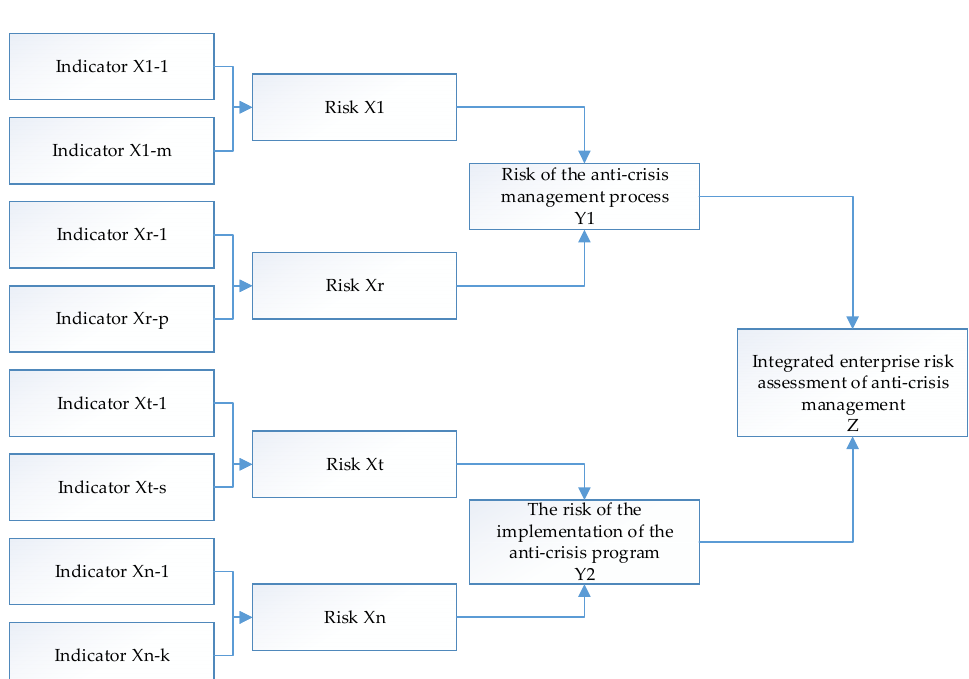
Figure 1. A generalized model of integral risk evaluation of the enterprise anti-crisis management (the authors’ development). Note: ( x 1 − 1 , . . . , x r − p )—process’ risk indicators of the anti-crisis